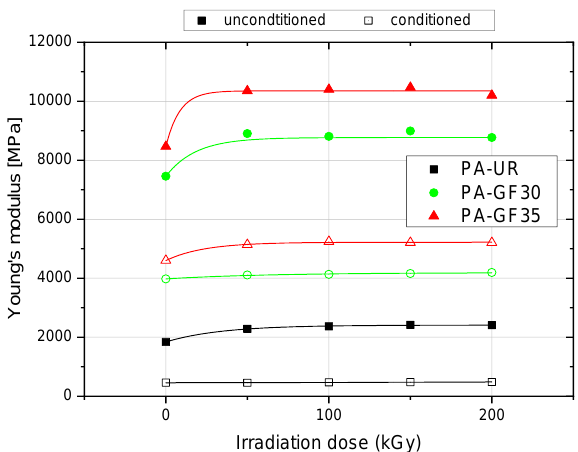
Figure 11. Young’s modulus at 23 °C for the three PA grades depicting the effect of water absorption and irradiation dose. Table 2. Overview of the tensile test data for the unconditioned and conditioned specimens Material state: Conditioned 2